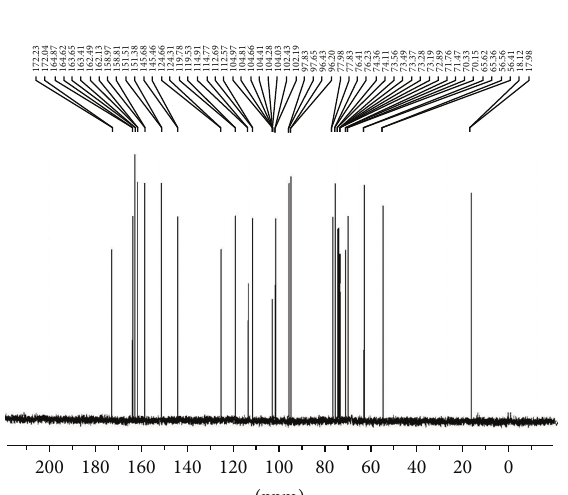
Figure 3: 1 H NMR of zinc-diosmin complex.